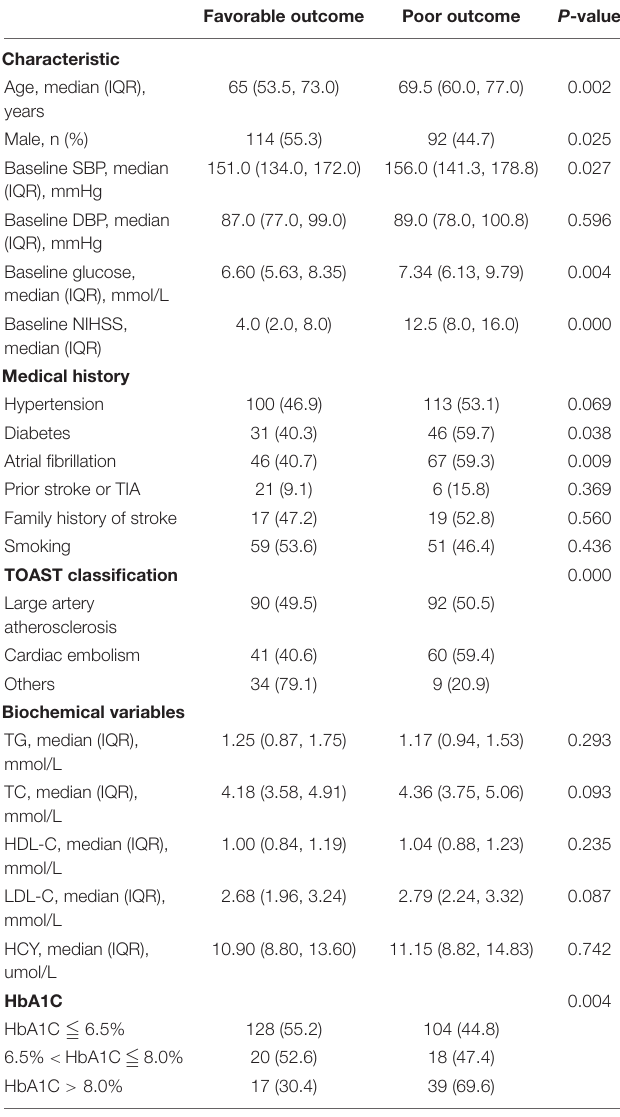
TABLE 2 | Baseline clinical and biochemical characteristics, stratified for functional outcome. Favorable outcome Poor outcome P